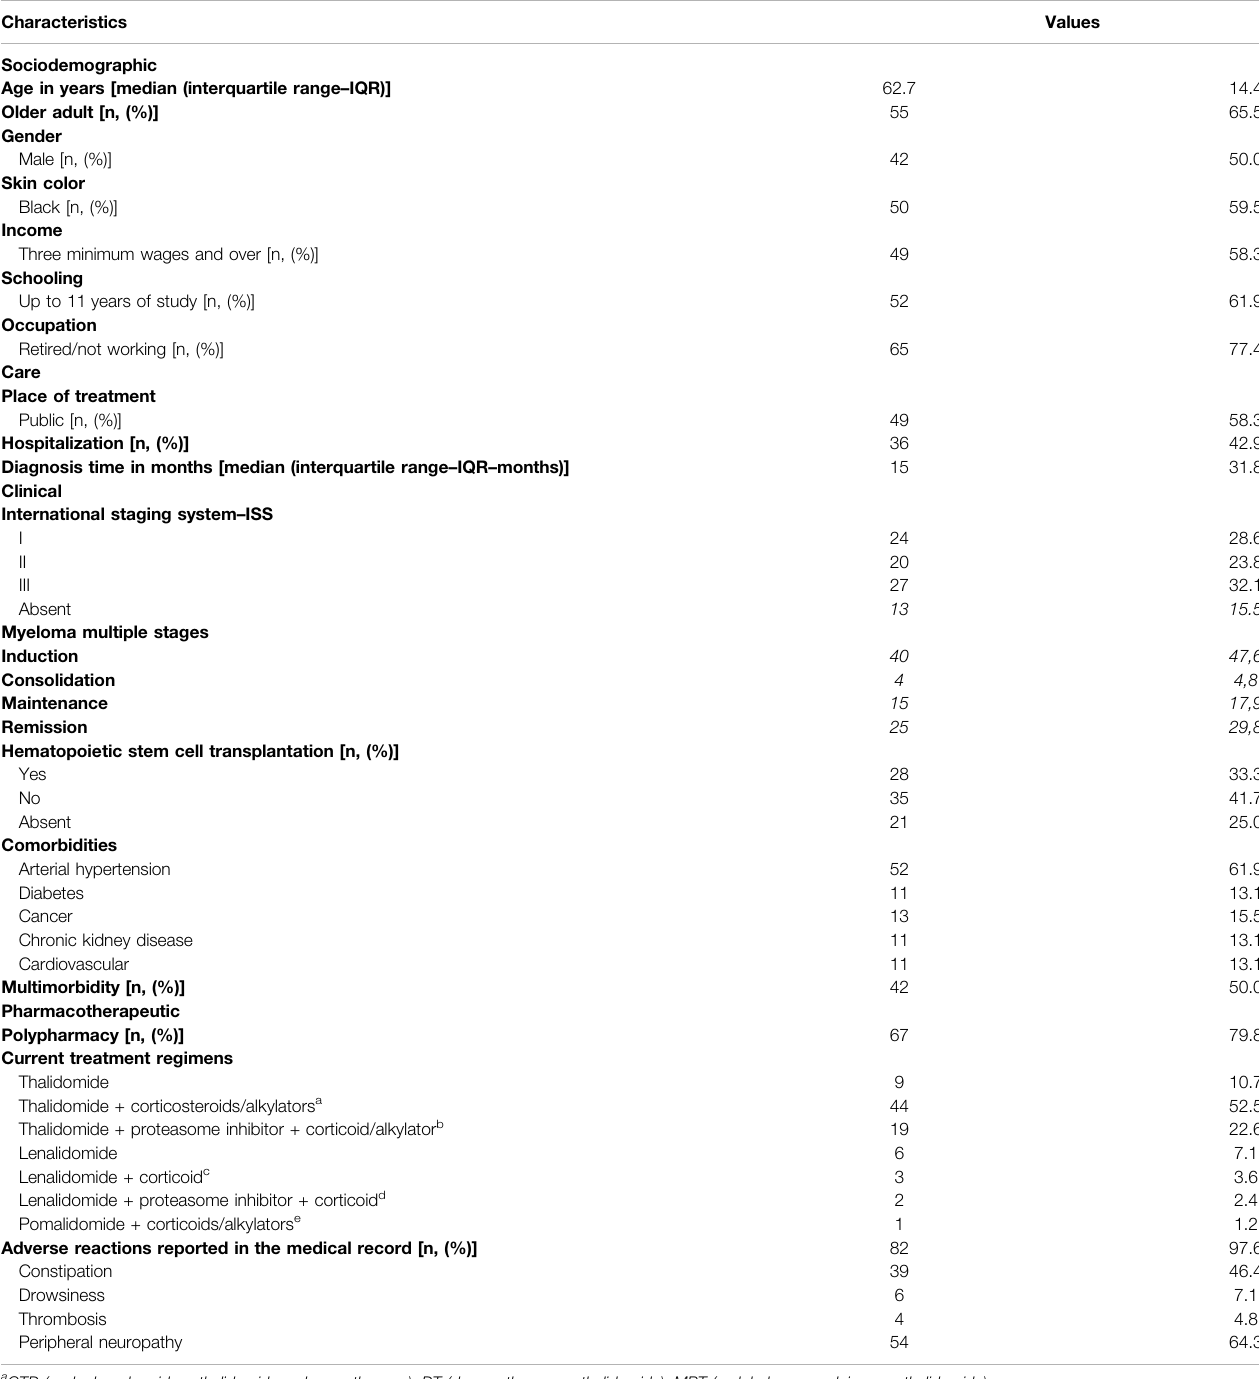
TABLE 1 | Sociodemographic, care, clinical and pharmacotherapeutic characteristics of patients with Multiple Myeloma using immunomodulators ( n (cid:1) 84).